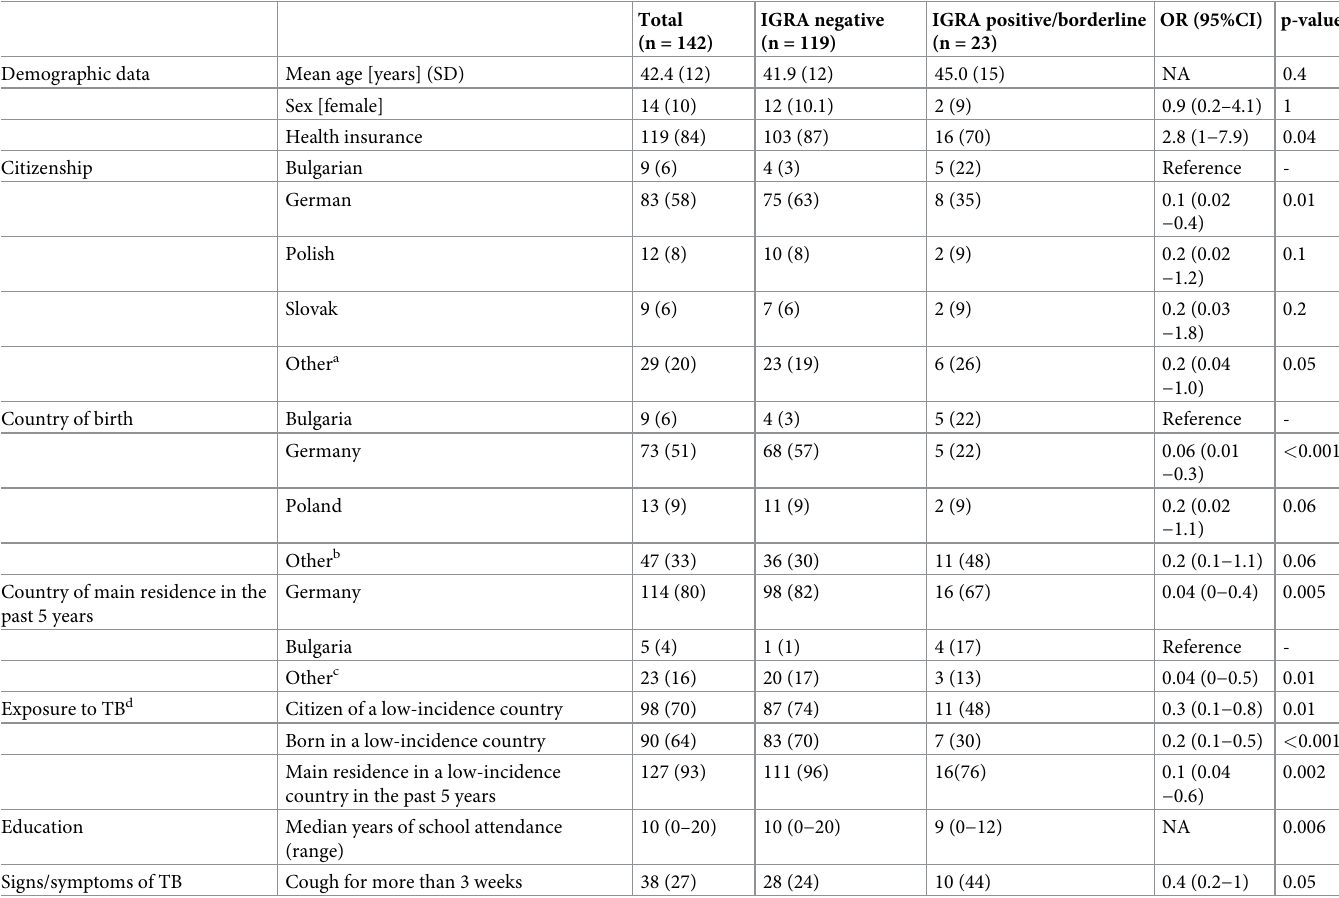
Table 1. Characteristics of the study population that showed significant association with Interferon- γ release assay (IGRA) results. (Further recorded data shown in